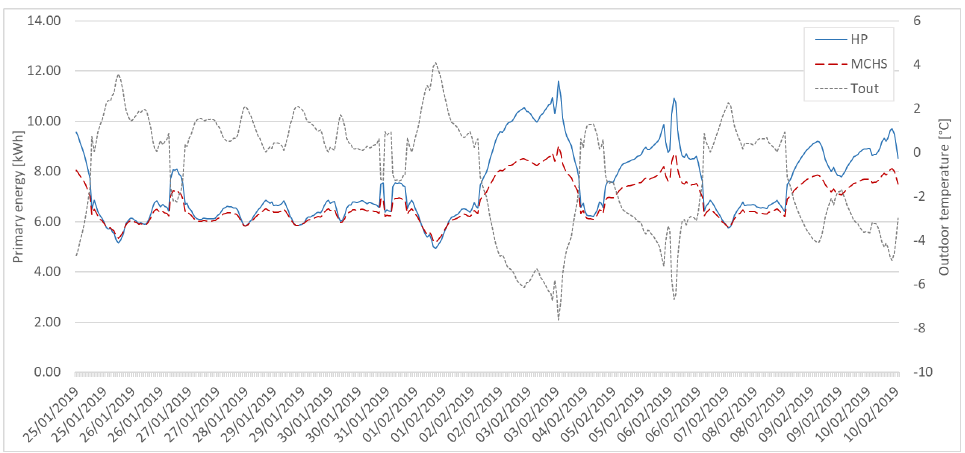
Figure 5. Hourly consumption of primary energy to cover the heating demand in Estonia for both non-electric heating systems (NEHS) and HP.